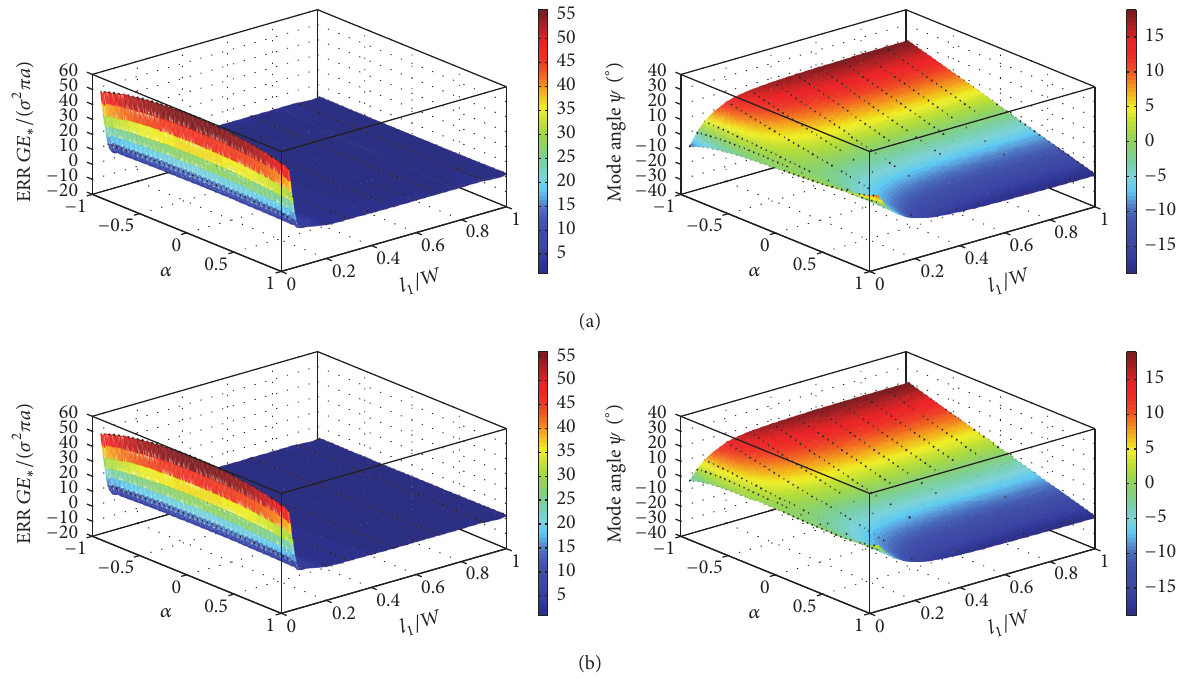
Figure 8: Normalized ERR 𝐺𝐸 ∗ /(𝜎 2 𝜋𝑎) and mode angle 𝜓 of a symmetrically bonded strip for (a) 𝛽 = 0.25𝛼 and (b) 𝛽 = 0.325𝛼 .